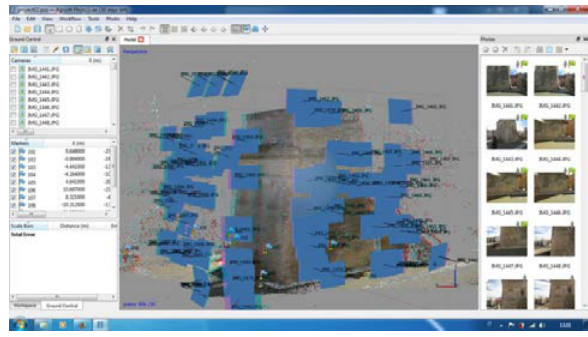
Figure 6: Pictures taken on the flight.